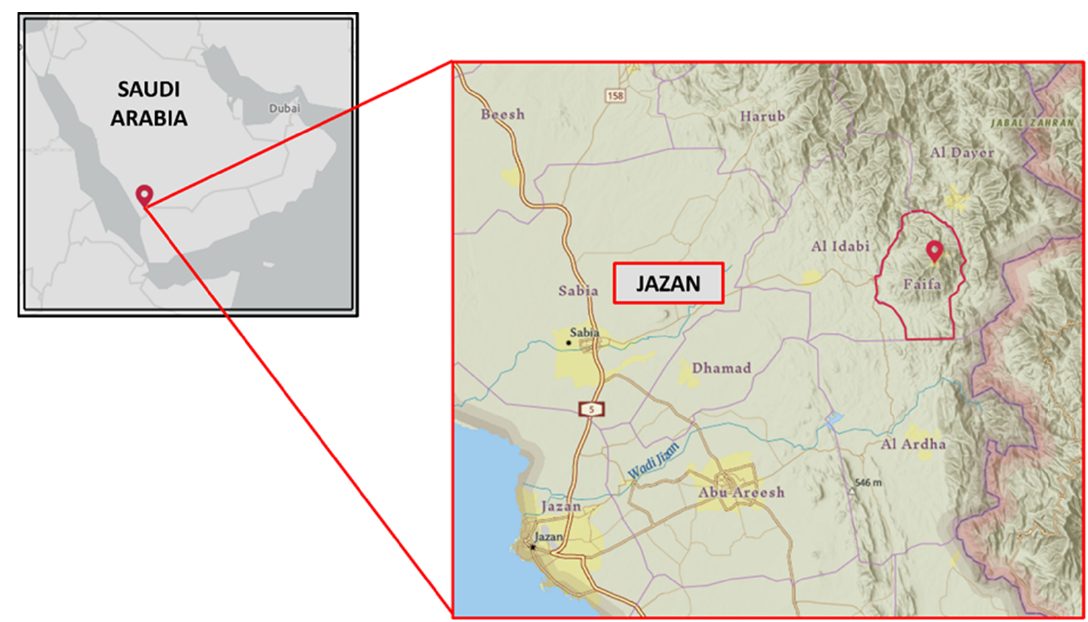
Figure 1. Geographical map of the Faifa mountains located in Jazan province, Saudi Arabia.